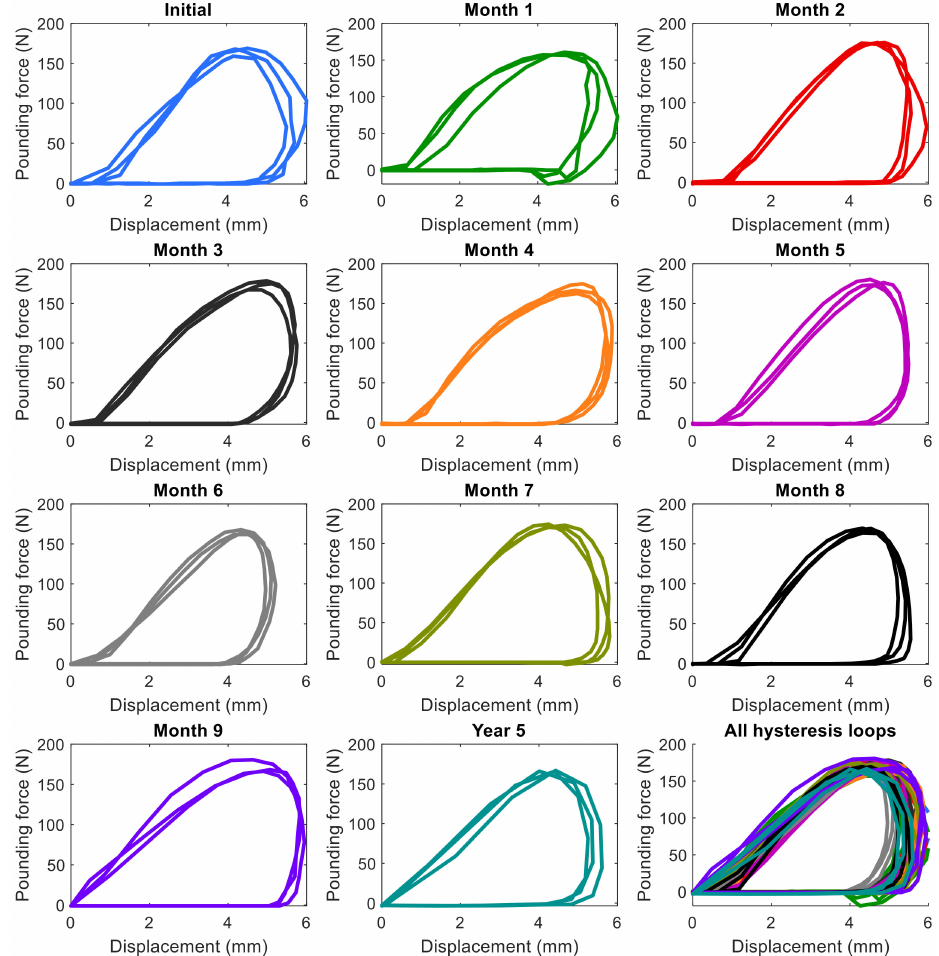
Figure 4. Hysteresis loops initially and submerged in